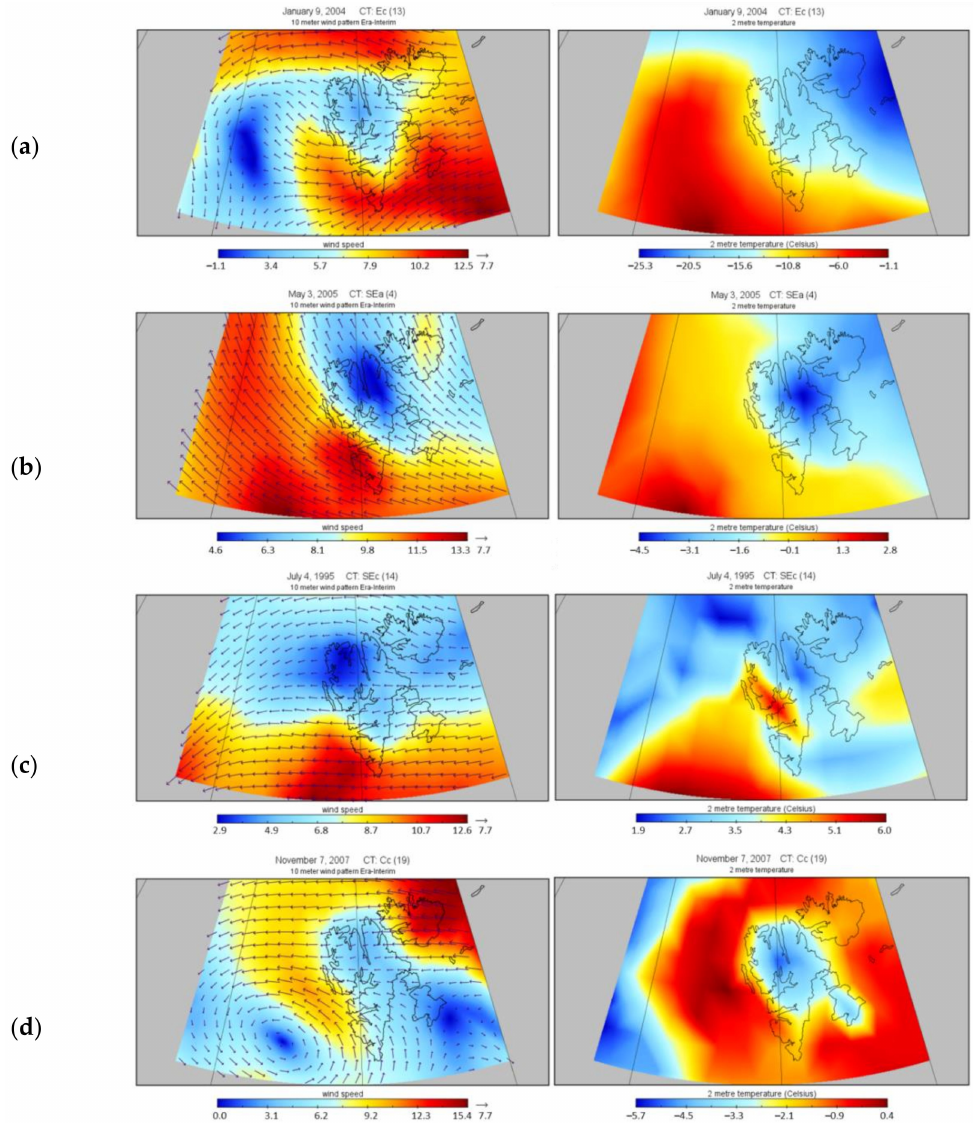
Figure 14. Distribution of 10 m wind speed and direction (left panels) and 2 m air temperature (right panels) obtained from Era-Interim with grid 0.125 ◦ × 0.125 ◦ . The following rows correspond to land-sea breeze type circulation events in consecutive seasons: ( a ) 9 January 2004, CT: Ec; ( b ) 3 May 2005, CT: SEa; ( c ) 4 July 1995, CT: SEc; ( d ) 7 November 2007, CT: